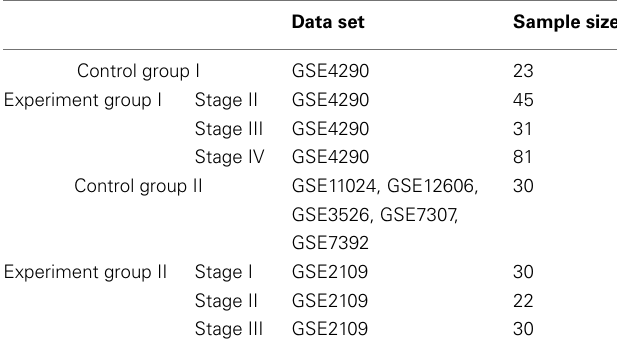
Table 1 |The data source.